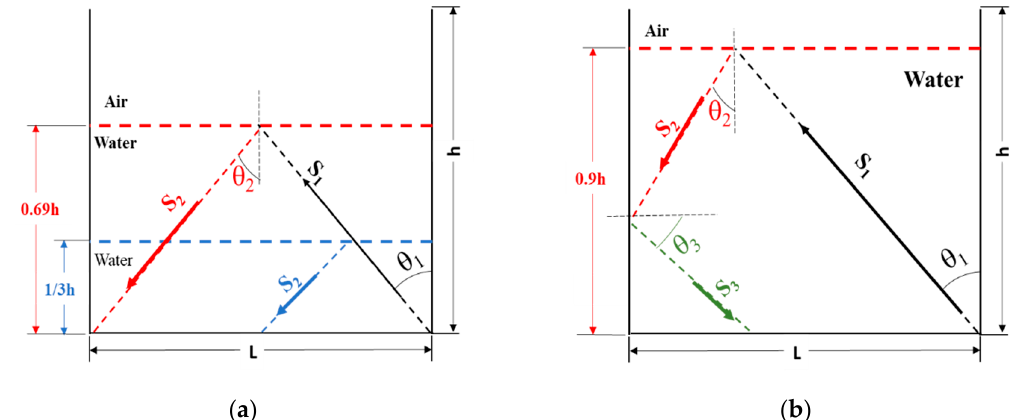
Figure 2. ( a ) Schematic representation of a wave traveling at a different level of liquid, including the critical case, which occurs at h < 0.86 L (first case); ( b ) Schematic representation of a wave traveling in the liquid when the liquid height is higher than 0.86 L (case 2).